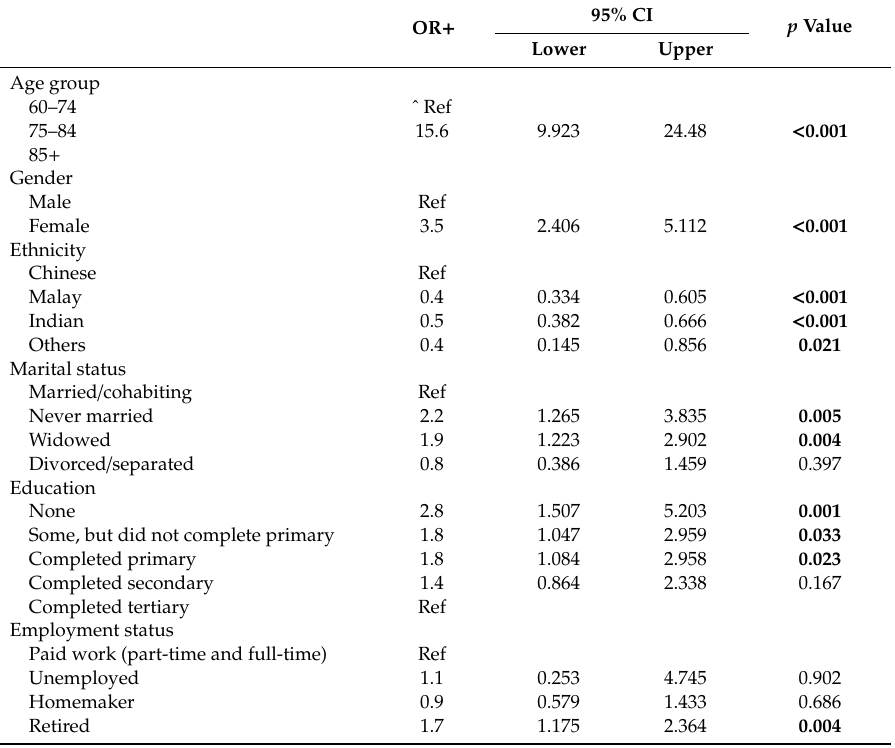
Table 2. Sociodemographic correlates to OSTA ≤ − 1 (at risk of osteoporosis). OR +